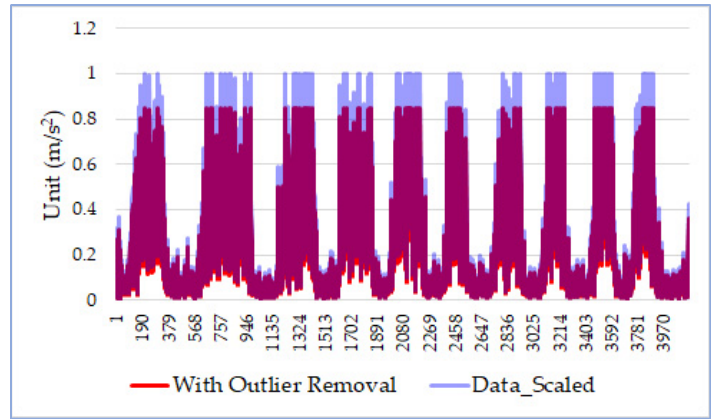
Figure 2. Data scaling.